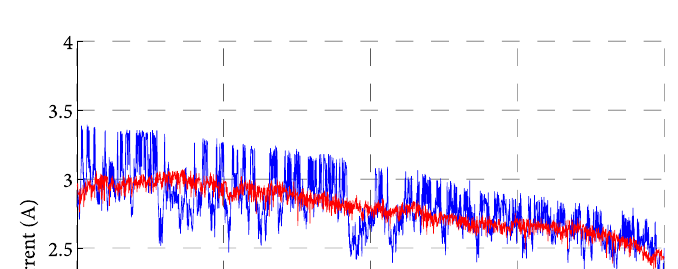
Figure 26. Current obtained from the PV module. Electronics 2018 , 7, 4